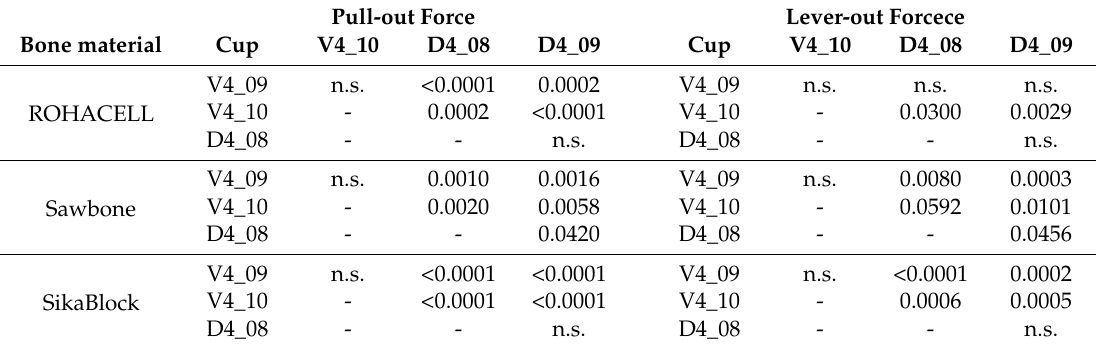
Table 5. Tabular listing of the p -values (one-way ANOVA with Bonferroni’s post hoc test) determined for lever and pull-out forces for the various press-fit cups and artificial bone bearings. The values of p < 0.05 were defined as significant (n.s.: not